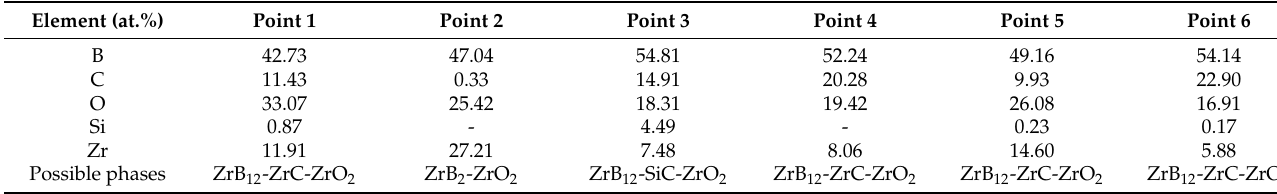
Table 3. EDS results of six positions in Figure 4d.